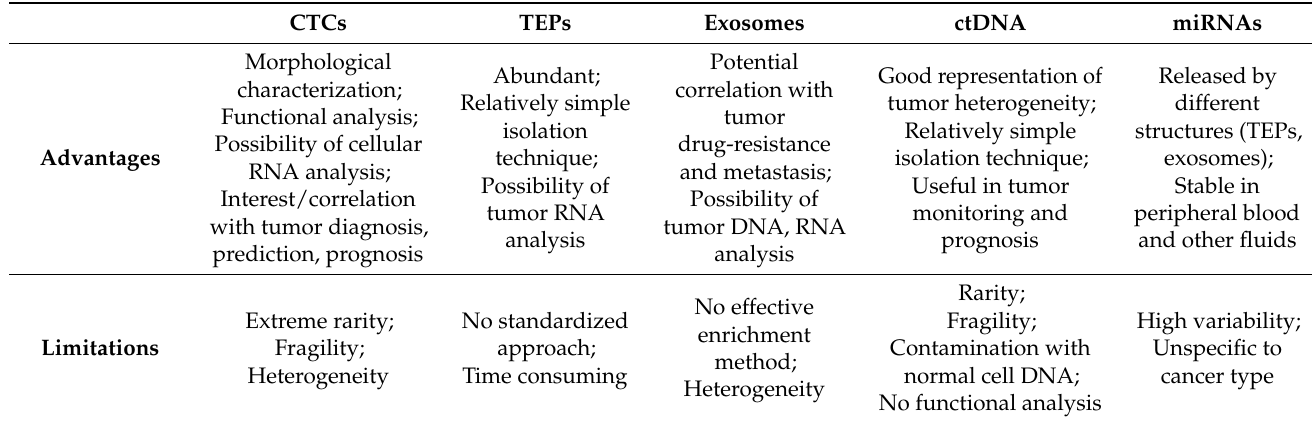
Table 2. CTCs and other relevant particles obtained via liquid